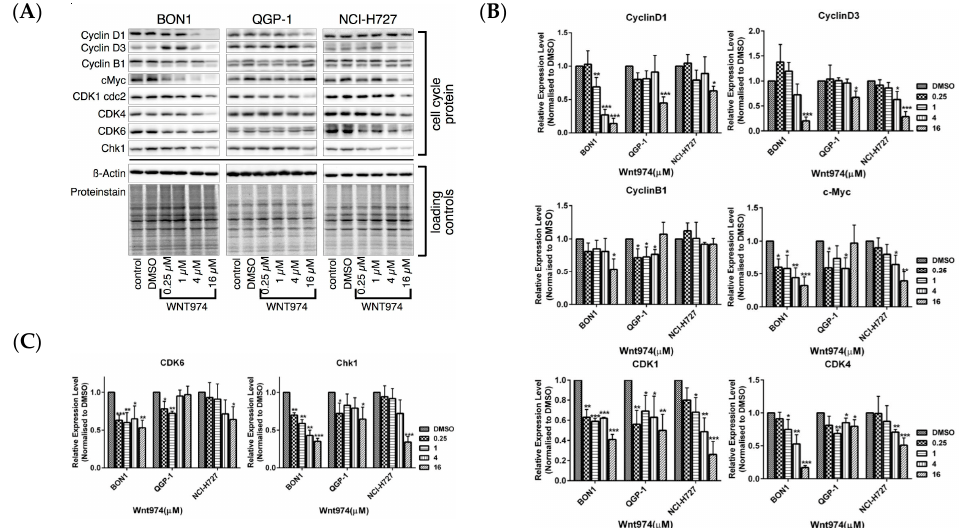
Figure 3. Effects of WNT974 on cell cycle proteins. BON1, QGP-1, and NCI-H727 cells were treated with or without WNT974 for 72h and then subjected to Western blot analysis. ( A ) A representative Western blot is shown. Equal protein loading was verified in all Western blots by normalization to the total protein staining and by the housekeeping protein β -actin . ( B , C ) Densitometric quantification of Western blot data was performed. The DMSO control was set as 1.0. Relative expression levels (normalized to DMSO control) of treated cells were calculated in %. * p < 0.05, ** p < 0.01, and *** p < 0.001 compared with that of DMSO controls.